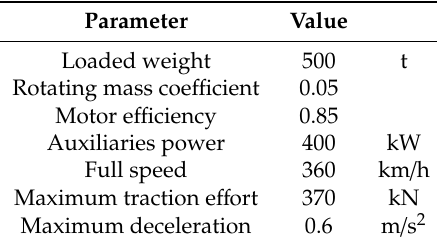
Table 6. Rolling stock data.